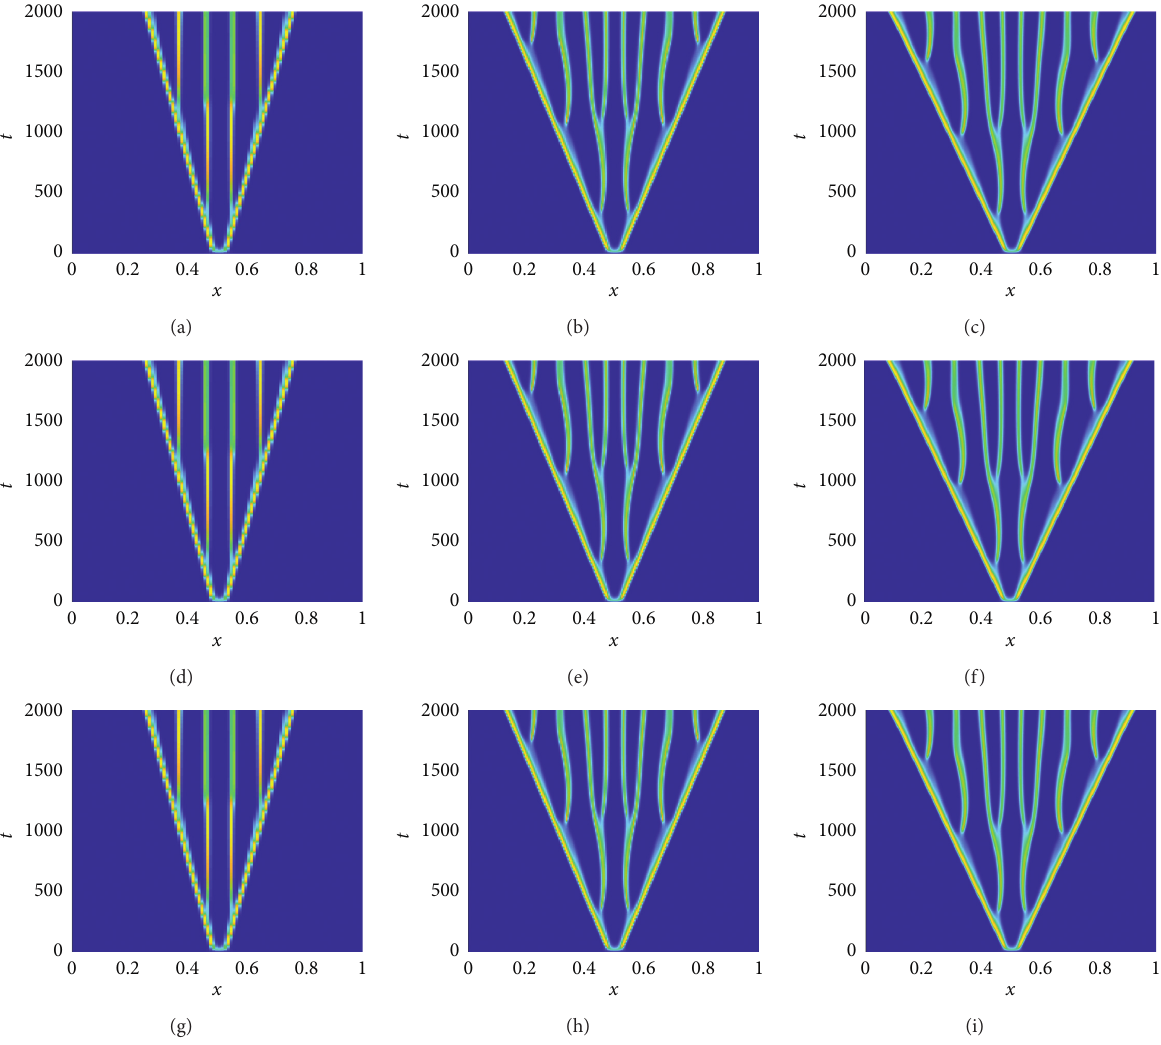
Figure 7: The wave-splitting (self-replication of the pulse) by the variable- θ method over 0 ≤ t ≤ 2000 with various ( Δ t, Δ x ) . The image I represents the numerical solution obtained with the mesh resolution ( Δ t, Δ x ) � ( 10 − k , 0 . 01/2 ℓ − 1 ) . (a) ( I 11 ). (b) ( I 12 ). (c) ( I 13 ). (d) ( I 21 ). (e) ( I 22 ). (f) ( I 23 ). (g) ( I 31 ). (h) ( I 32 ). (i) ( I 33